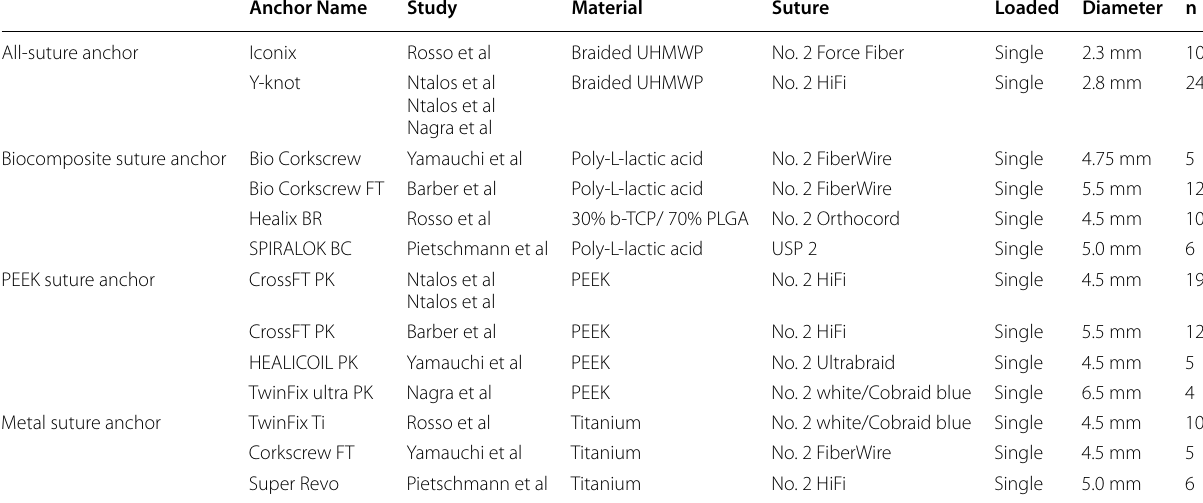
Table 2 Descriptive characteristics of the included suture anchors